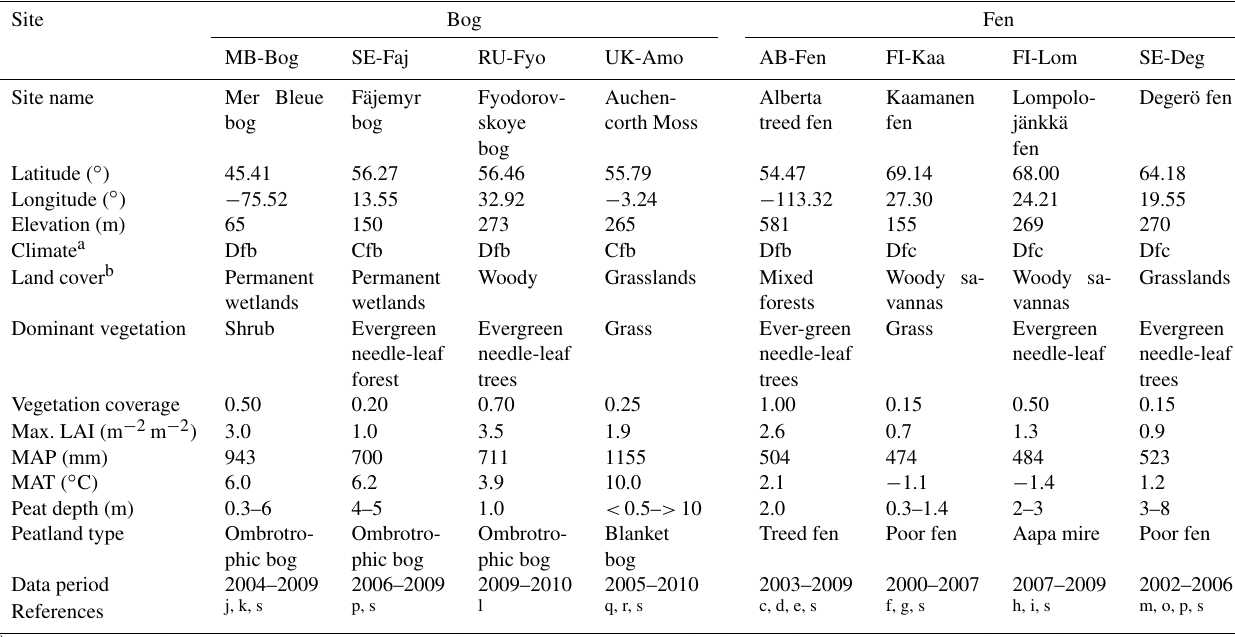
Table 4. Descriptions of the test